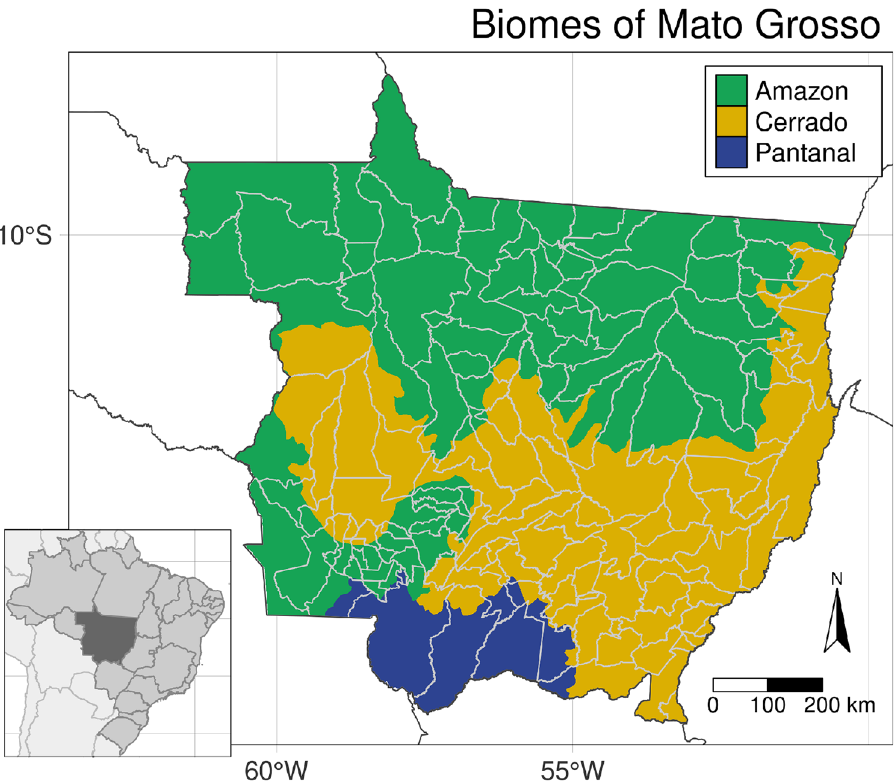
Figure 1. Mato Grosso lies at the intersection of the Amazon rainforest, the Cerrado tropical savannah, and the Pantanal wetlands (coloured). The frontier state is located in the centre-west of Brazil (see inset) and is subdivided in 141 municipalities (gray lines). Created using the tmap (version 3.3-2) R (version 4.1.1) package 25,26